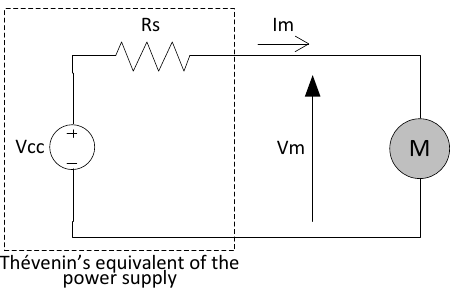
Figure 1. Thévenin’s equivalent of the source and brushed dc (direct current) motor.